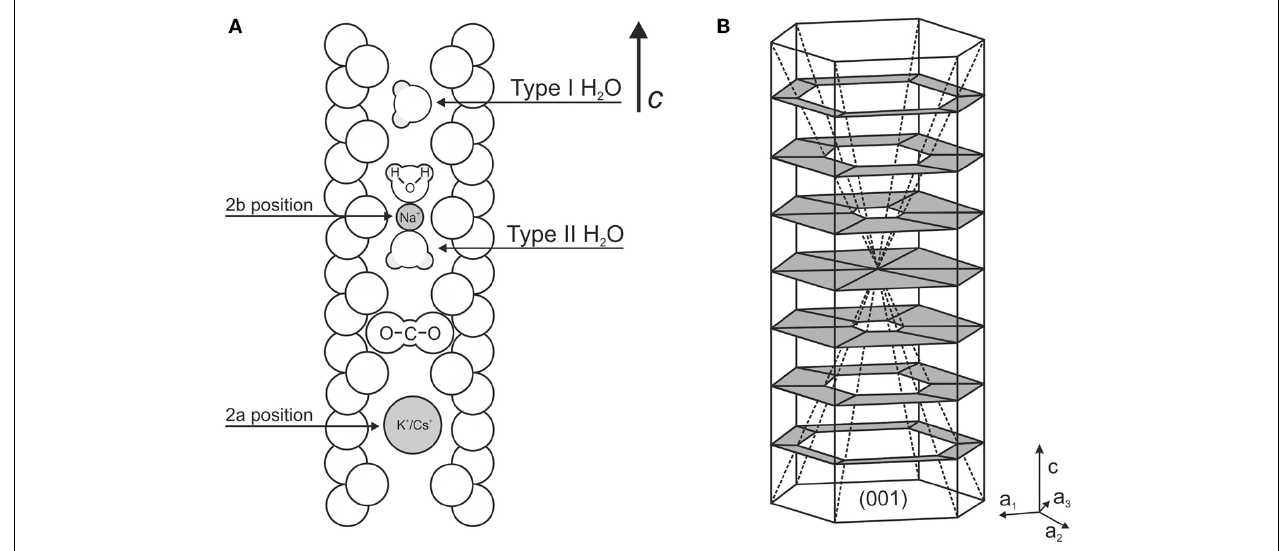
FIGURE 1 | (A) Schematic section of beryl channel parallel to [001], modified after Fukuda and Shinoda (2011). (B) Sketch of the hourglass zoning within beryl (modified after Hollister, 1970).